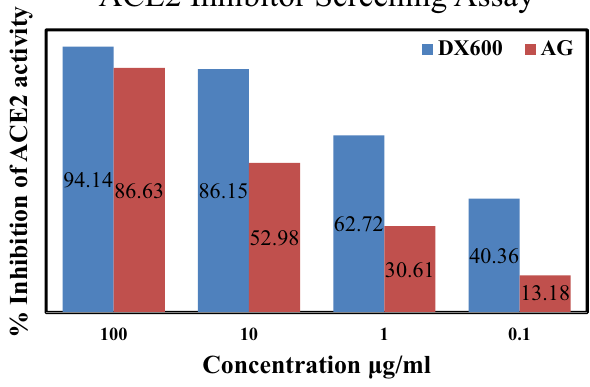
Figure 6: Arabic gum ( AG ) in comparison to DX600 noncompetitively inhibits ACE2. DX600 IC 50 = 0.235 ± 0.01 μ g · mL − 1 and Arabic gum IC 50 = 4.688 ± 0.24 μ g · mL − 1